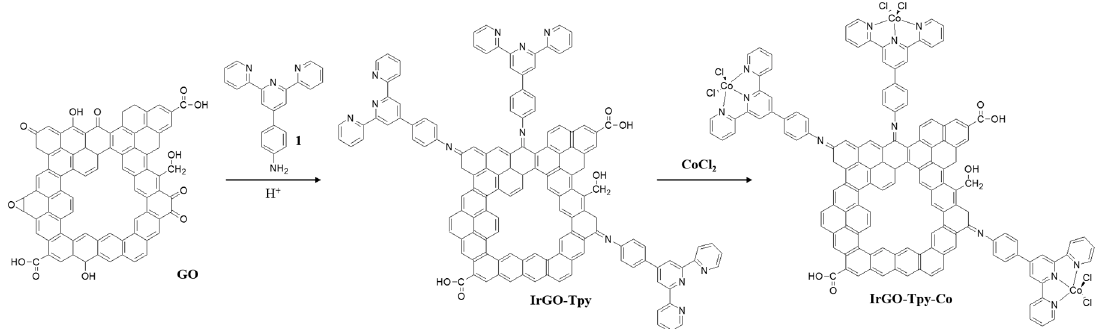
Figure 1. Synthesis of terpyridine ‐ containing imine ‐ rich graphene (IrGO ‐ Tpy) and the related Co(II) complex (IrGO ‐ Tpy ‐ Co).